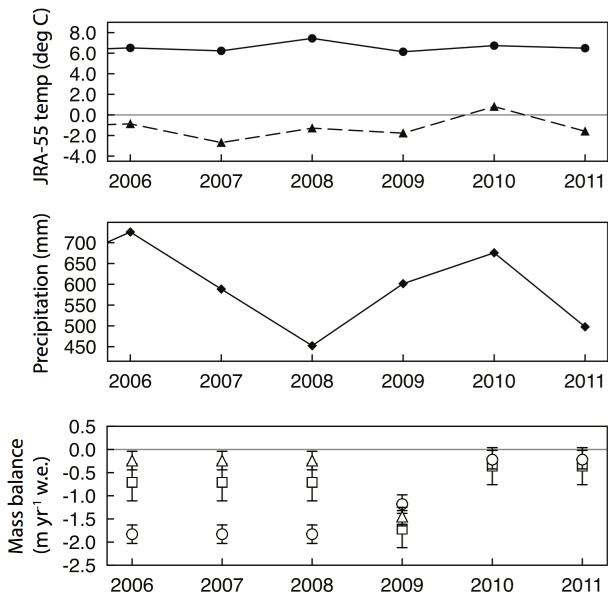
Figure 7. Time series of JRA-55 seasonal air temperatures (upper panel: JJA, solid line and dots; SON, dashed line and triangles), JRA-55 precipitation (middle panel, diamonds), and geodetic mass balances (lower panel) at Abraham (squares), Hidden (circles), and Minaret (triangles) glaciers, between 2005/2006 and 2011. Note that 2005–2008 and 2009–2011 values are annually averaged, cal- culated between geodetic measurements at the start and end of both